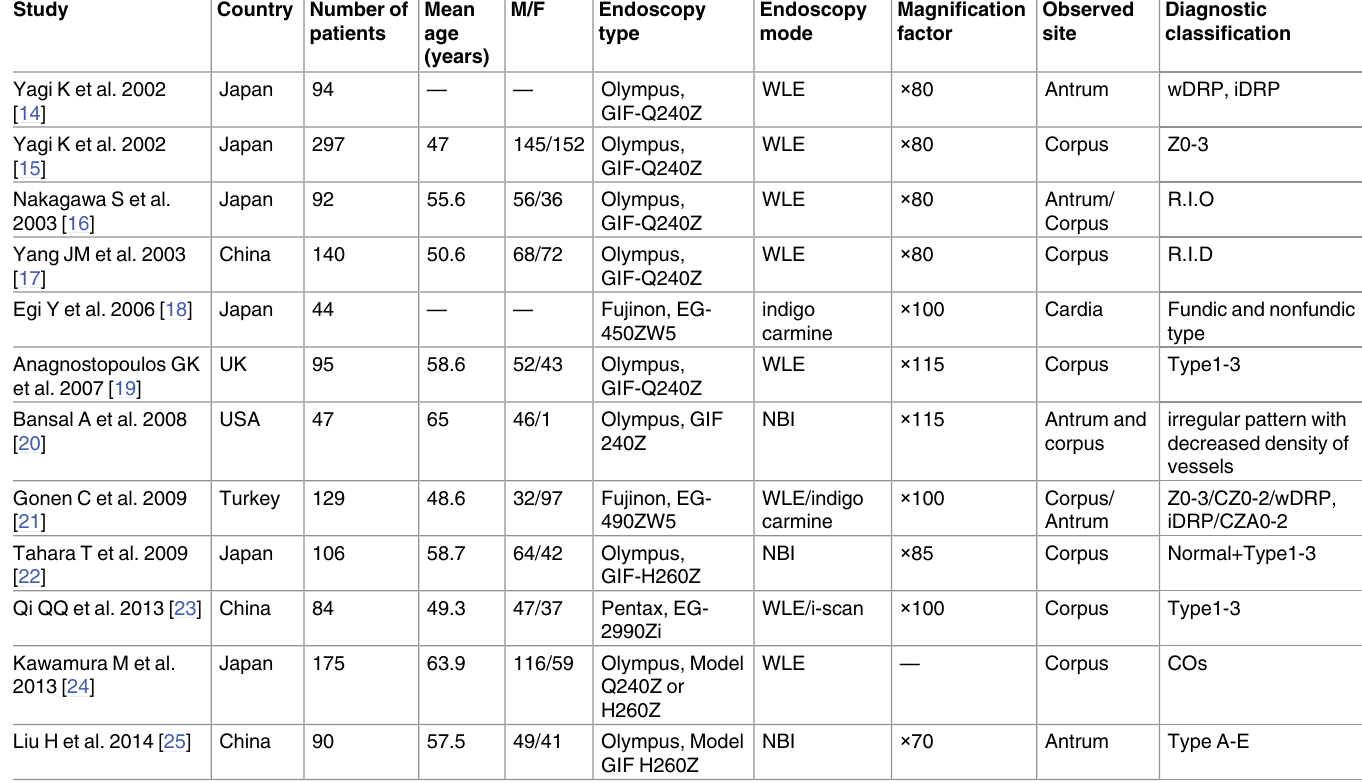
Table 1. Characteristics of the included studies.